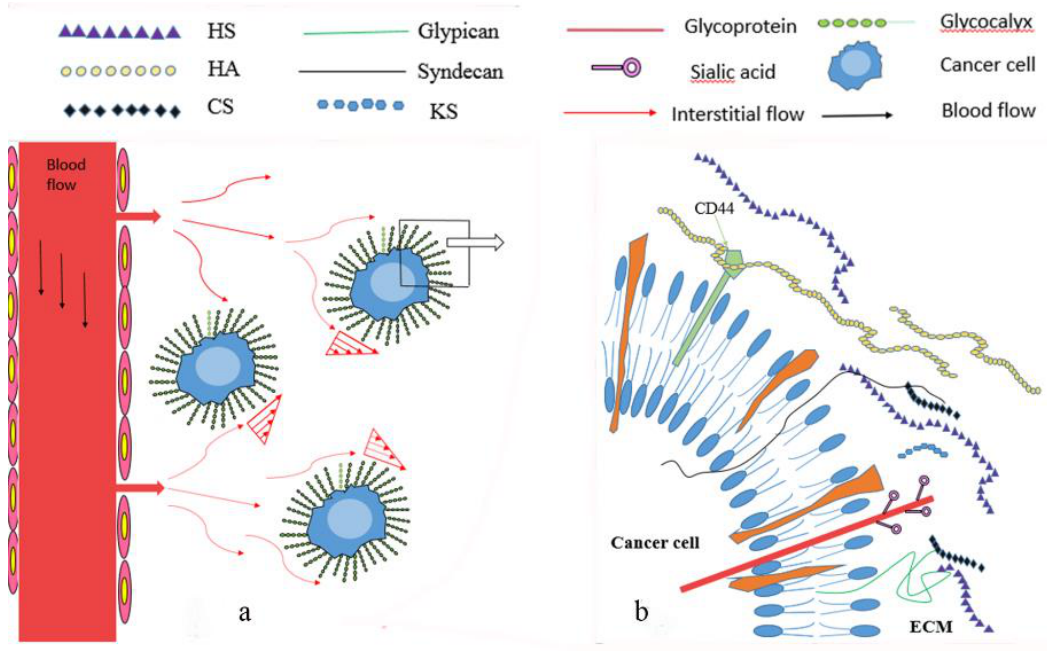
Figure 1. ( a ) Cancer cells are exposed to interstitial flow and glycocalyx can sense interstitial flow induced shear stress. ( b ) Glycocalyx is composed of proteoglycans and glycoproteins, like HS, HA, and KS. Syndecans and glypicans are the major core CS and KS. Syndecans and glypicans are the major core proteins.